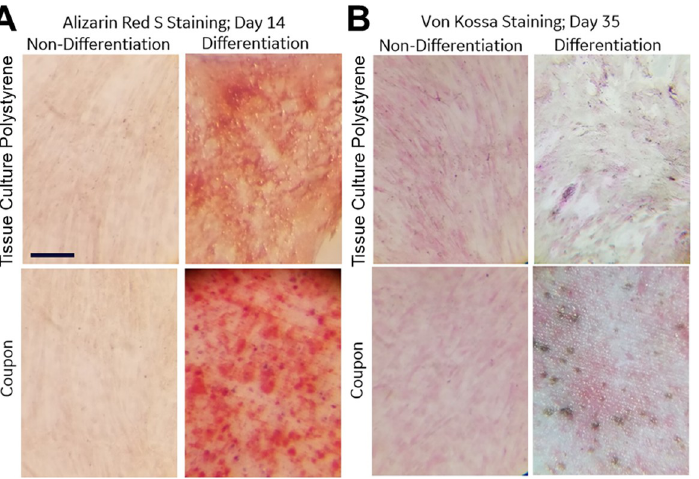
Fig 6. Calcium deposition from osteogenic differentiated MSCs on DLP printed coupons. (A) Calcium deposits stain red when cells are stained with Alizarin Red S and (B) gray to black with von Kossa. (B) The von Kossa counter stain, nuclear fast red, stains cells a fuchsia color. The observation of punctate staining in MSCs cultured in osteogenic differentiation medium on DLP printed coupons and polystyrene plates demonstrates calcium deposition on both surfaces using both Alizarin Red S and von Kossa staining. In contrast, MSCs cultured in growth media lack similar punctate calcium staining with either Alizarin Red S or von Kossa. Images were taken using Lecia dissection scope at 4x magnification, scale bar